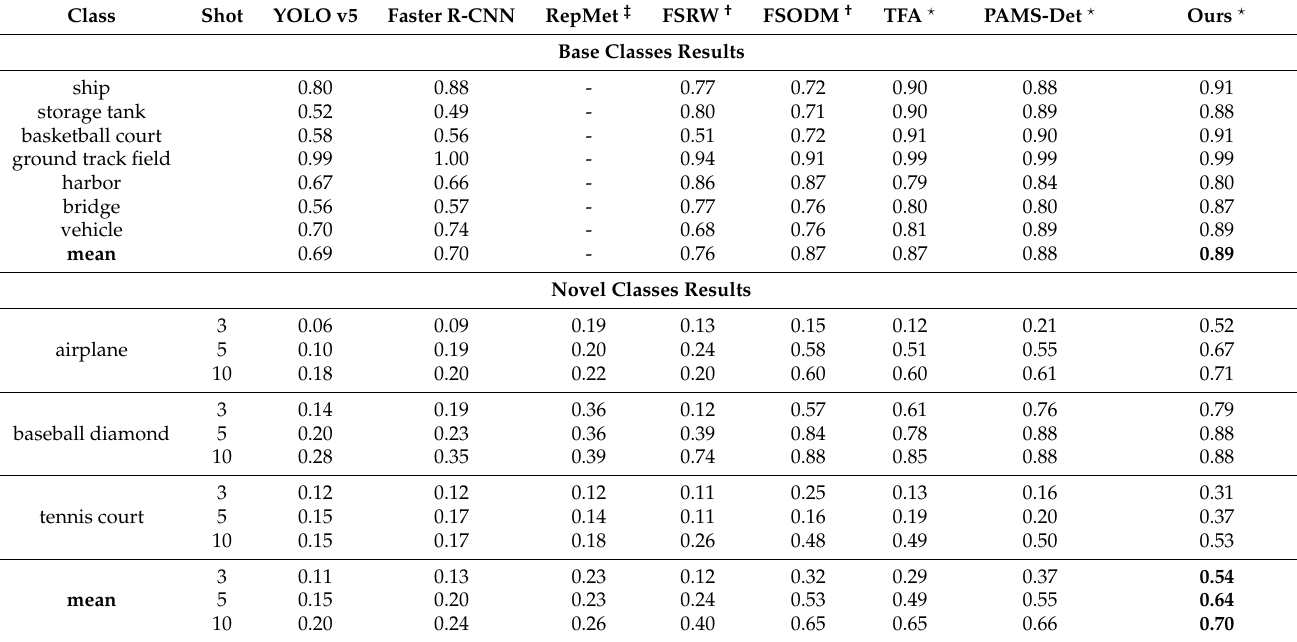
† marks meta-learning based methods. ‡ marks metric-learning based methods. (cid:63) marks the average of the experiments on 10 random